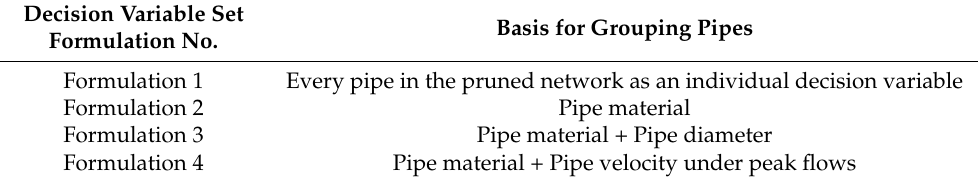
Table 1. Four different ways of defining decision variables. Decision Variable Set Formulation